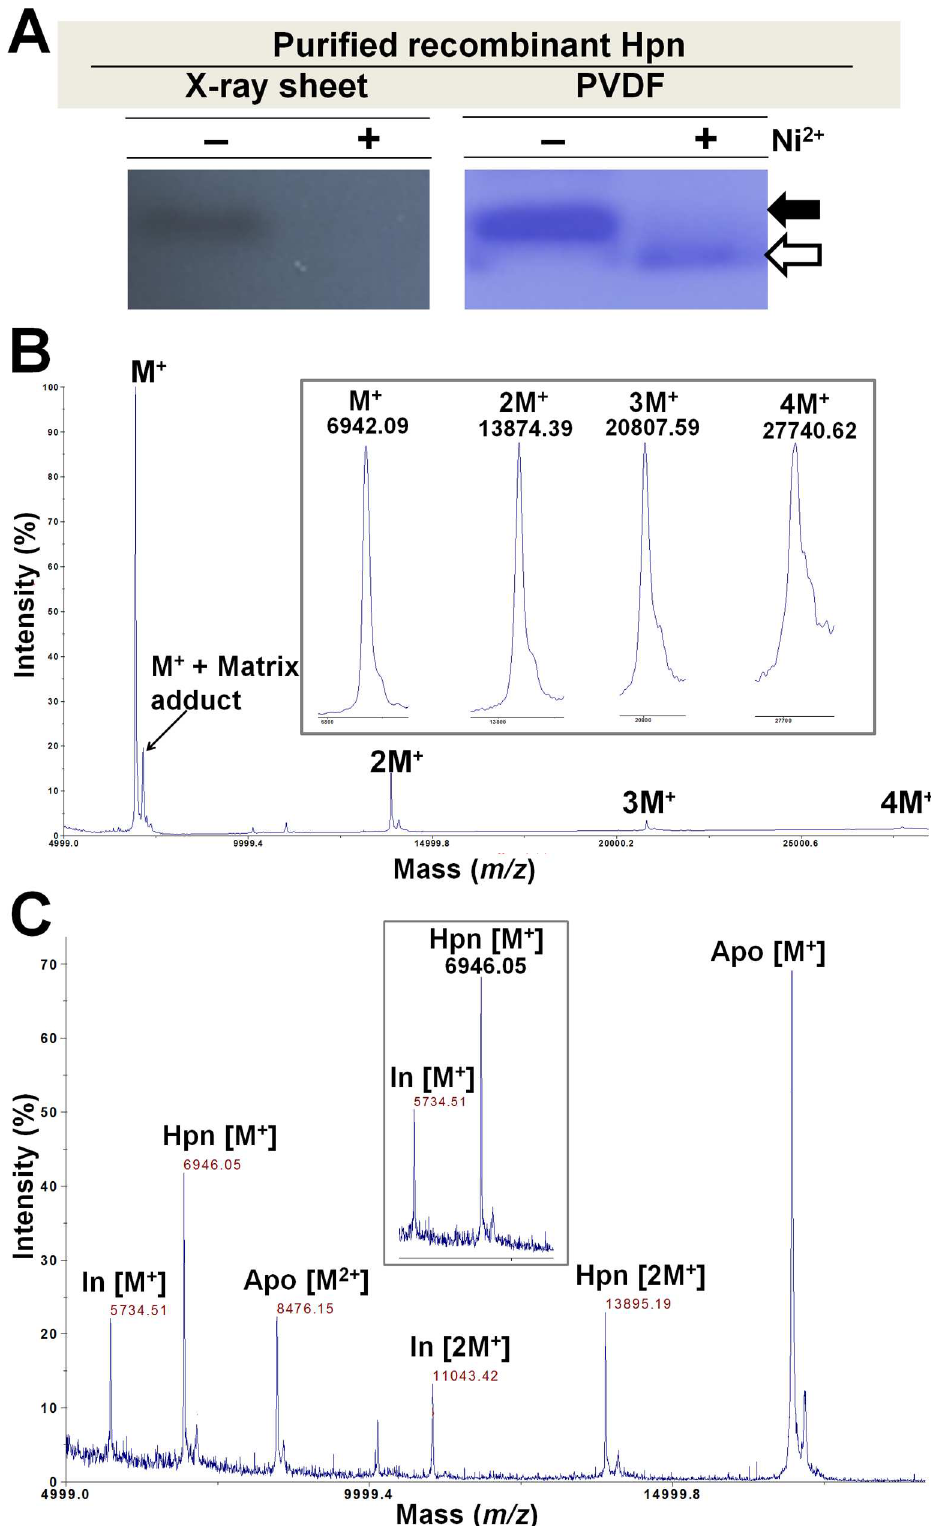
Fig 2. Western blot and molecular mass analysis of Hpn with MALDI-TOF-MS. A. Western blot of Hpn was done using His.Tag ® monoclonal antibody. In left panel, X-ray sheet showingECL detectionresult